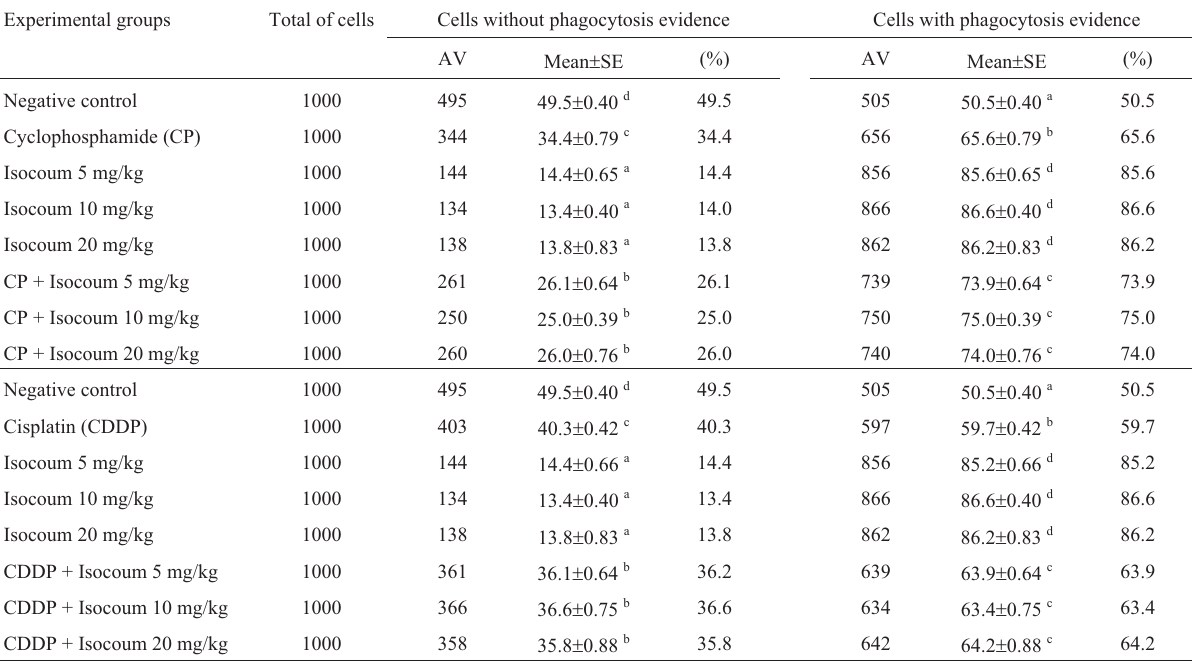
Table 5 - Analyzed cell numbers, absolute values (AV), mean frequency (cid:5) SE, and cell percentages with or without evidence of splenic phagocytosis in Swiss mice treated with different doses of isocoumarin. Experimental